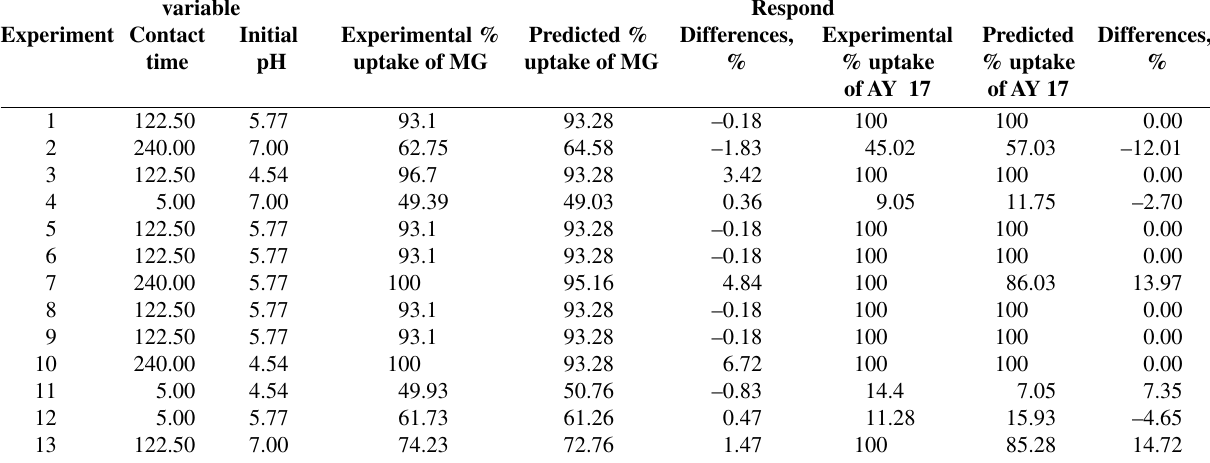
Table 6. Central composite design (CCD) matrix for two independent variables and the observed respond on MG and AY 17 in binary dye